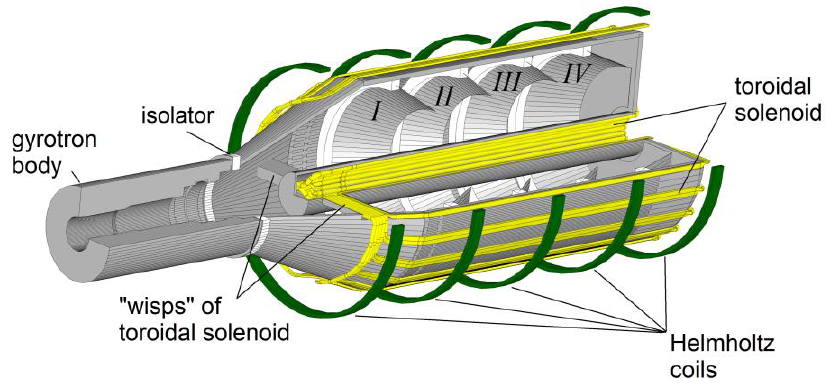
Fig. 2. Schematic drawing of the collector